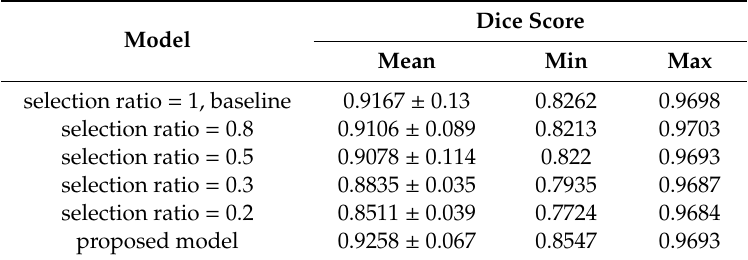
Figure A2. U-net architecture. Each blue box corresponds to a multi-channel feature map. The number of channels is denoted on top of the box. The x-y-size is provided at the lower left edge of the box. White boxes represent copied feature maps. The arrows denote the different operations. Table A1. Kidney segmentation results on test dataset based on different selection ratio using FCN model.